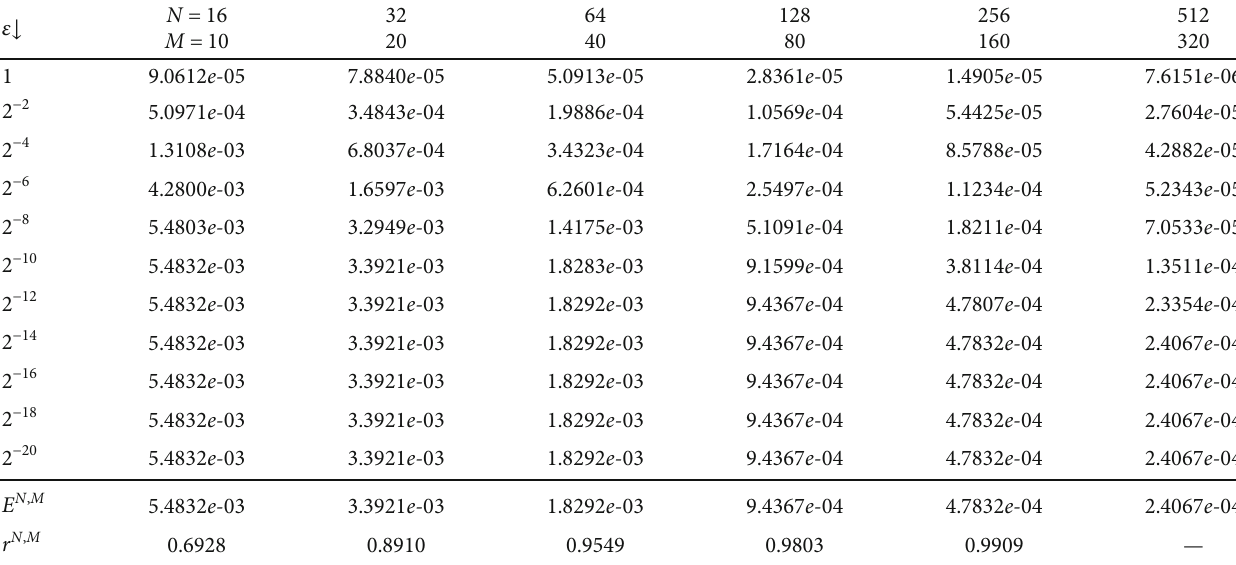
Table 2: Example 20, maximum absolute errors of the